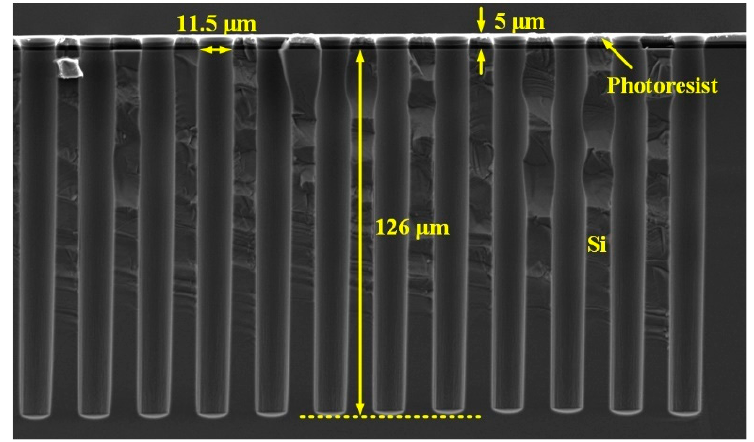
Figure 6. Cross sectional SEM image of the blind vias etched by DRIE.